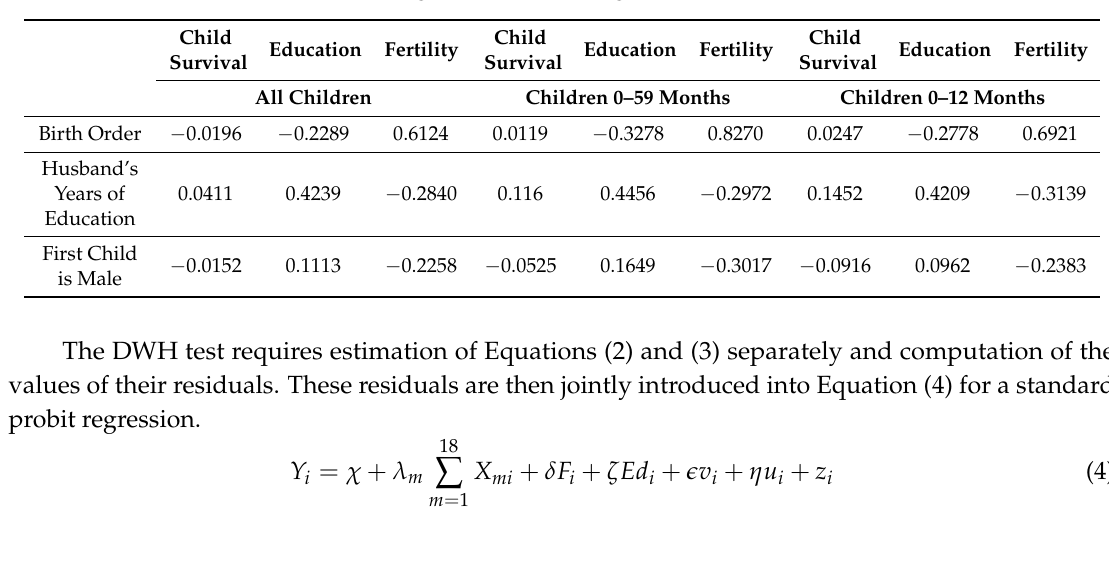
Table 1. Correlation Matrix of Endogenous Variable/Regressors and Selected Instrumental